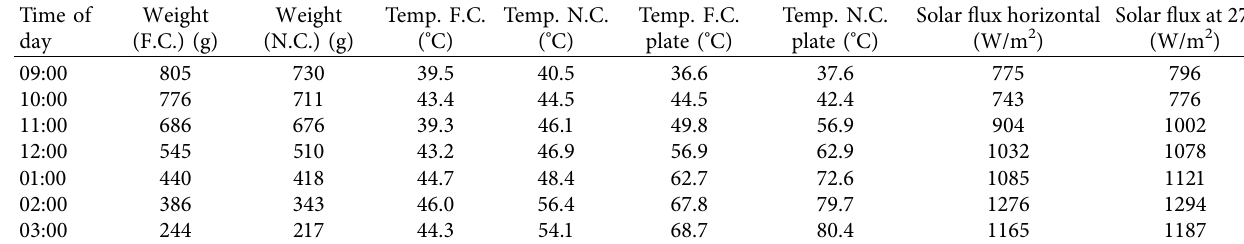
Table 8: Observation of red chillies in a solar dryer.